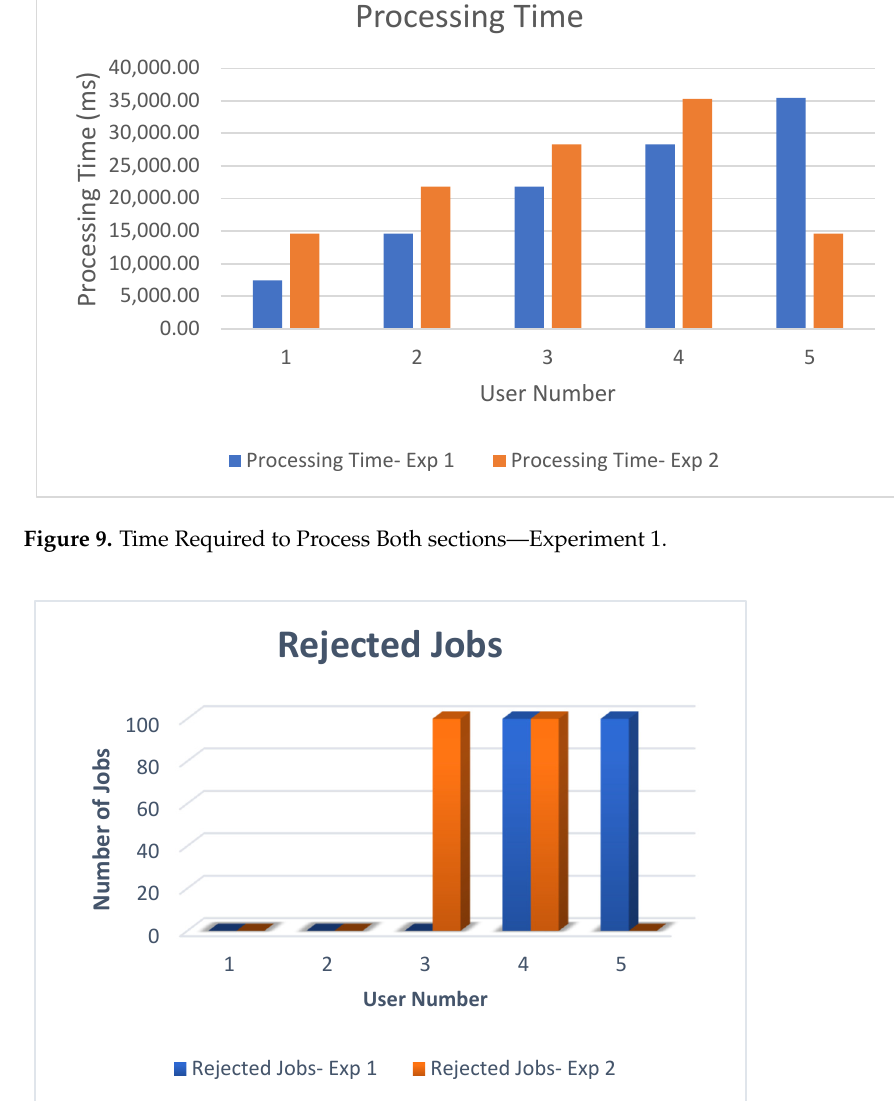
Figure 10. Job Rejections for Both sections—Experiment 1.